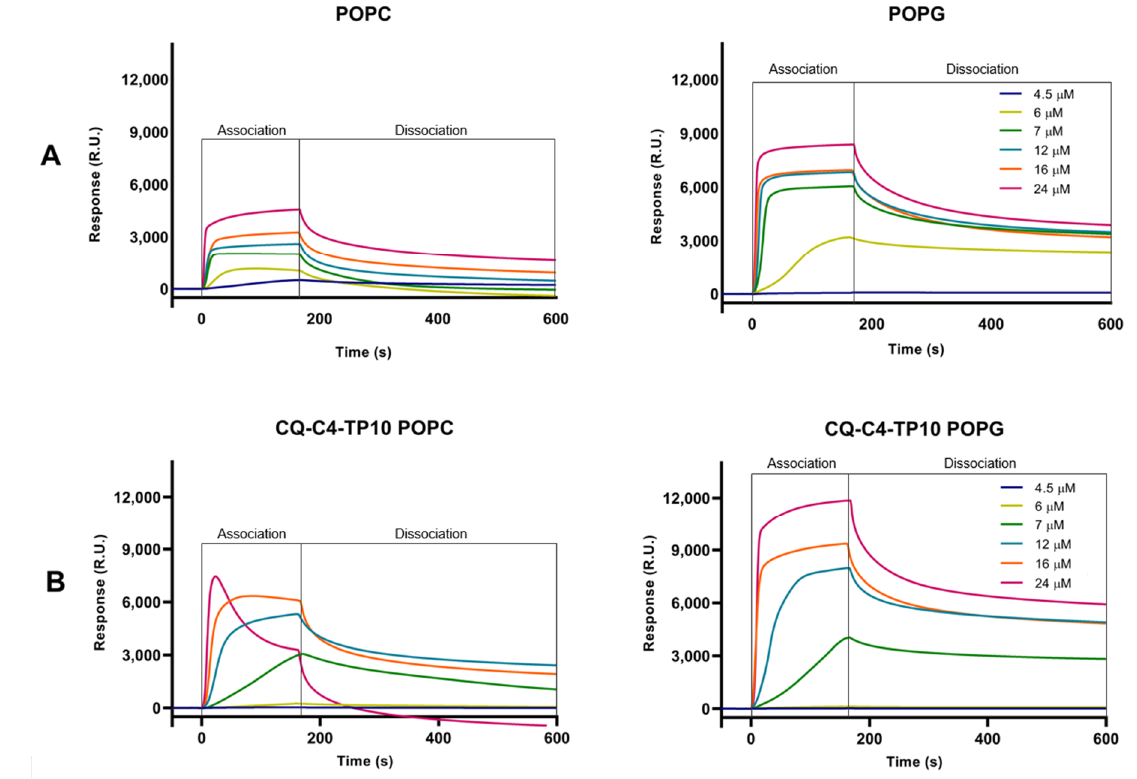
Figure 3. SPR sensorgrams obtained for ( A ) TP10 and ( B ) CQ-C4-TP10 binding to POPC and POPG model membranes at six different concentrations ranging from 4.5–24 µM. While the interaction of increasing concentrations of CQ-C4-TP10 with POPG membranes results in a typical sensorgram (as does TP10 upon interaction with both types of membranes), the same does not happen for POPC membranes: at 16 µM, slight POPC membrane disruption is observed as a decrease in response units (RU) during the association phase; at 24 µM, it is possible to observe that this conjugate acts like a “detergent”, disrupting the zwitterionic membranes and removing them from the sensor chip (negative RU).